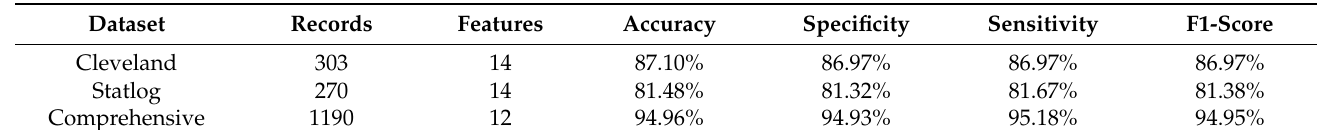
Table 4. The 1D-CNN model performance analysis.